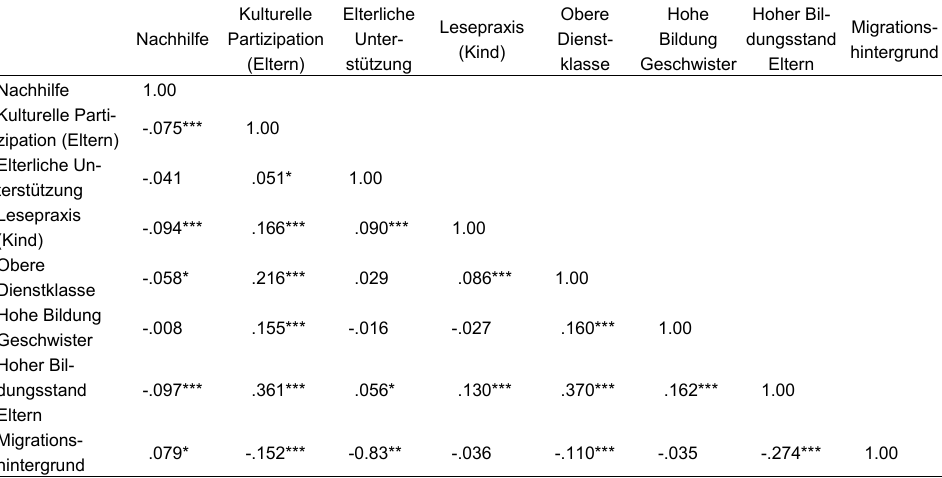
Tabelle 4: Interkorrelationen der exogenen Variablen im Pfadmodell